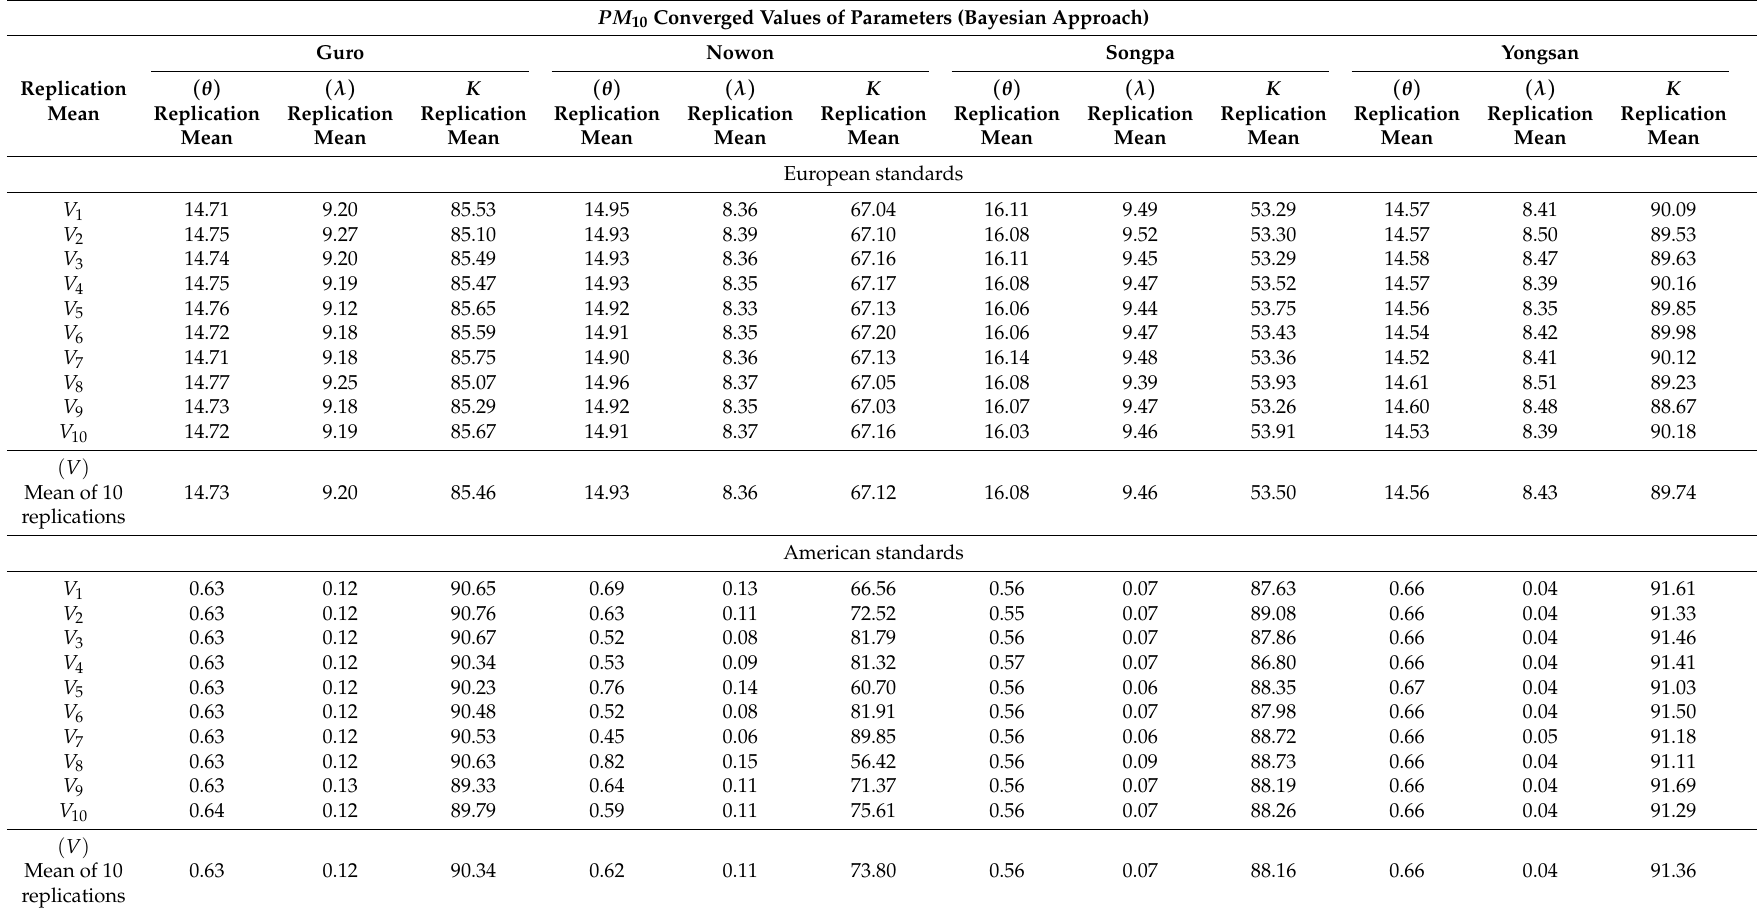
Table 10. PM 10 Converged values of parameters (Bayesian